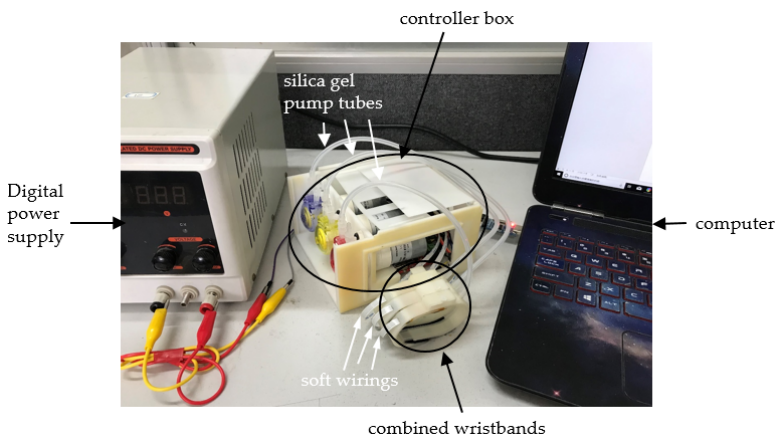
Figure 2. A wearable combined wrist pulse measurement system.